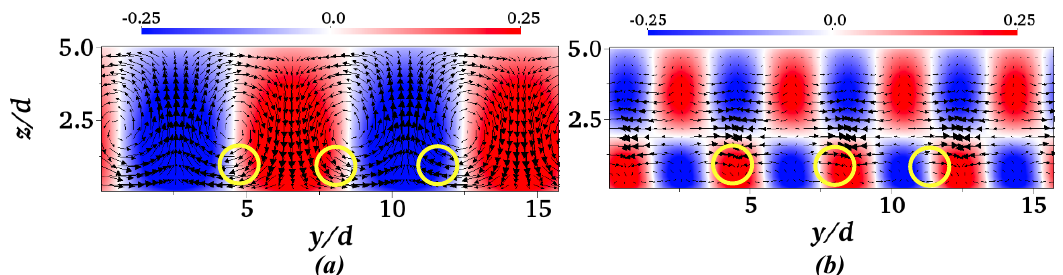
Figure 18. Reconstructed 3D POD modes from 2D Fourier-POD modes at yz plane, x = 7.85 d , ( a ) m = 0, k y d = 0.8, ( b ) m = 1, inverse FFT, inverse FFT ∀ Thick yellow circles—turbine locations.